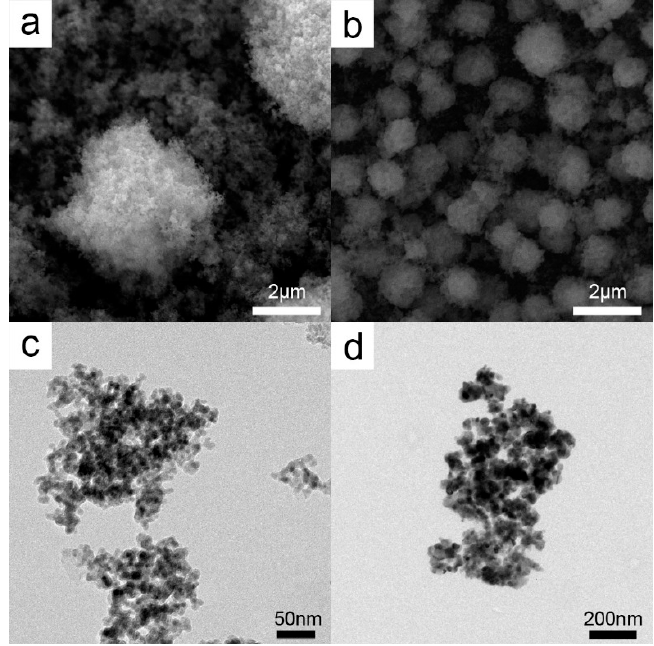
Figure 2. SEM images of ( a ) Cu@Cu 2 O; ( b ) calcined HKUST-1 and TEM images of ( c ) Cu@Cu 2 O; ( d ) calcined HKUST-1.